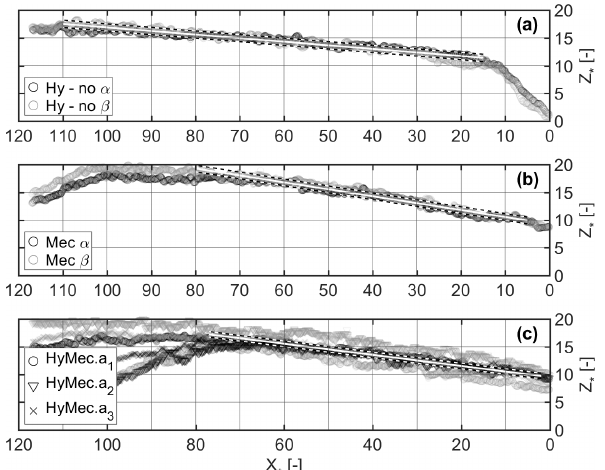
Figure 14. Relative deposit height Z ∗ at the longitudinal axis of the guiding channel ( Y ∗ = 0) after the repetitive α and β hydrograph tests; upstream of (a) the non-overflowed hydraulic barrier (Hy-no); (b) the mechanical barrier only (Mec); and (c) the combined barrier (HyMec) with varying opening heights a 1 , 2 , 3 . The linear regres- sion curves of the aggradation zones are shown (white lines), with indication of the corresponding 68% confidence intervals (dashed